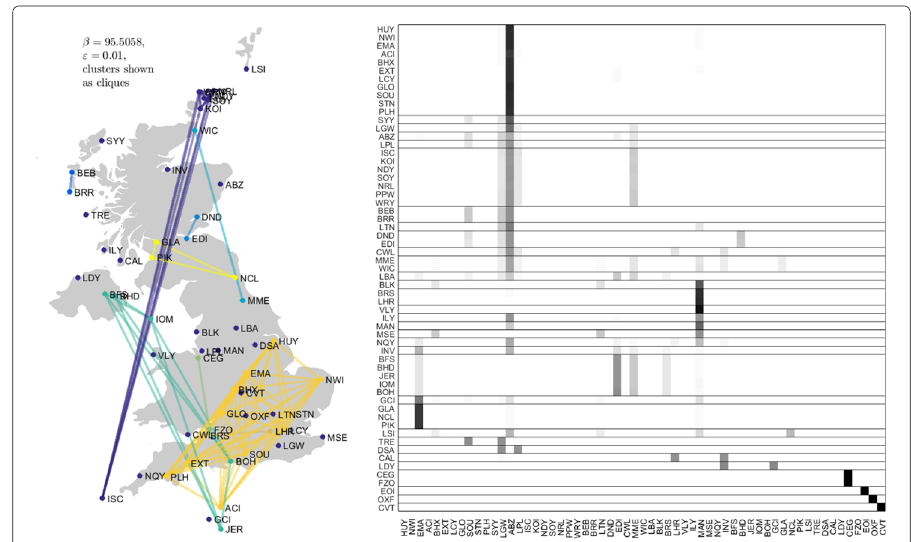
Fig. 9 Clusters from UK flight data for Friday, 22 October 2010; otherwise as in Fig. 5. Cluster colors only distinguish clusters from each other and do not suggest affinity across